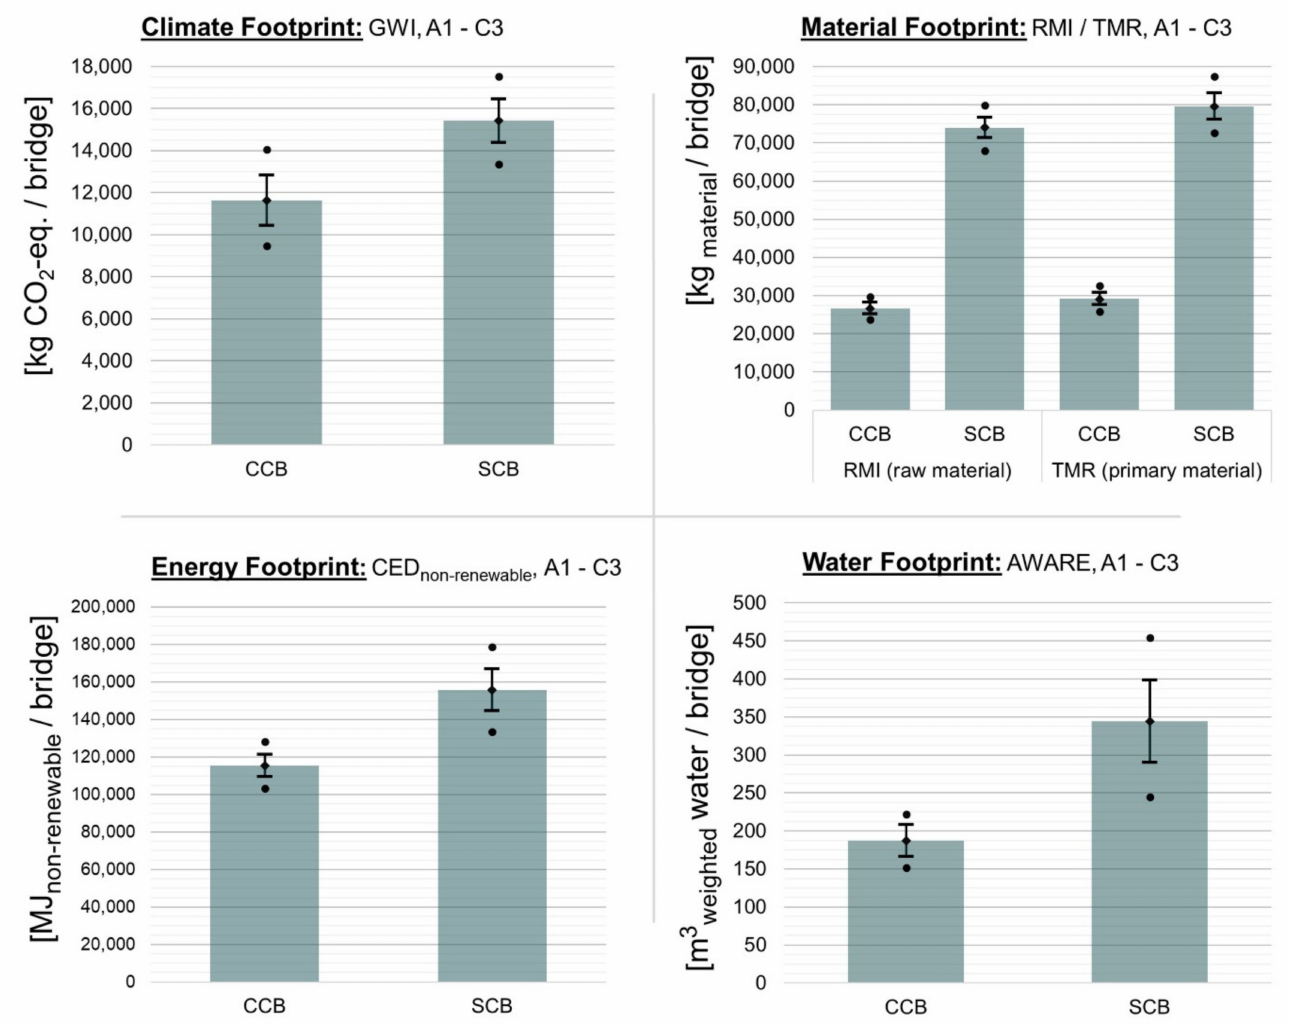
Figure 4. Uncertainties of the footprint results of a pedestrian bridge made from carbon concrete (CCB) and from reinforced concrete (SCB). A1-C3: entire life-cycle. GWI: global warming